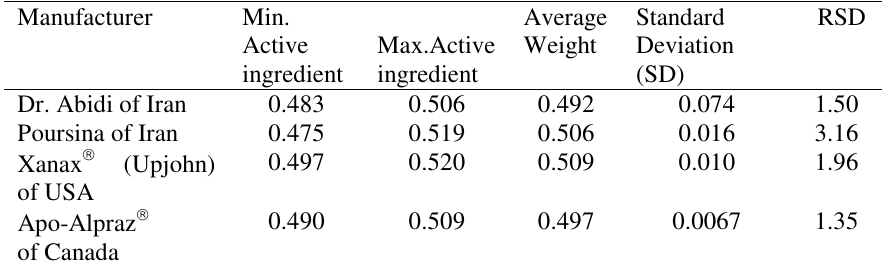
Table 7 . Results obtained from the content uniformity test of alprazolam tablets (mg)